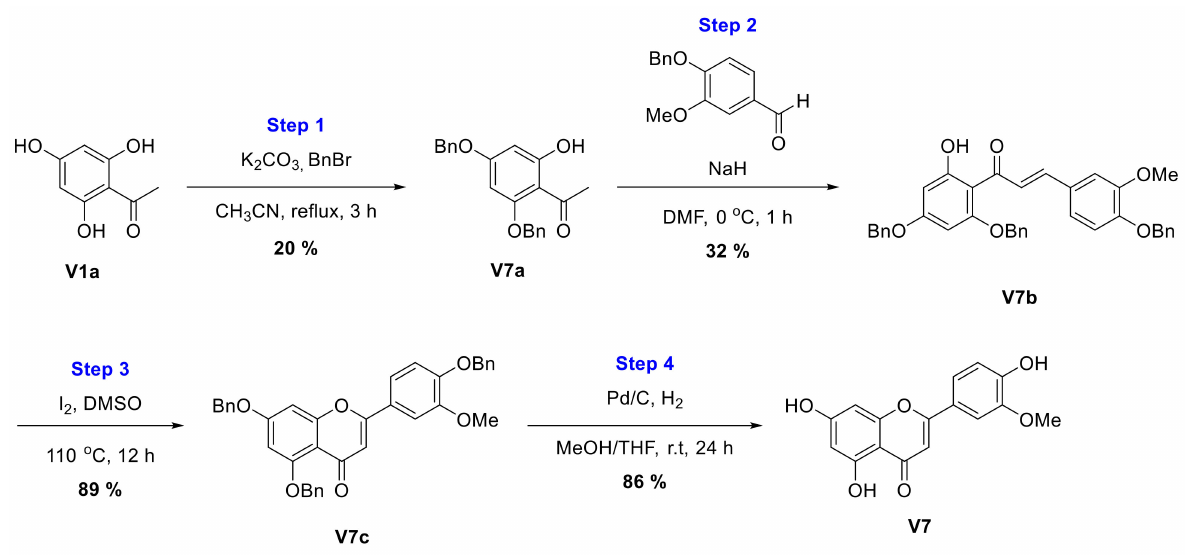
Scheme 4. Synthesis of V4 , V6 , V7 , V9 , and V10